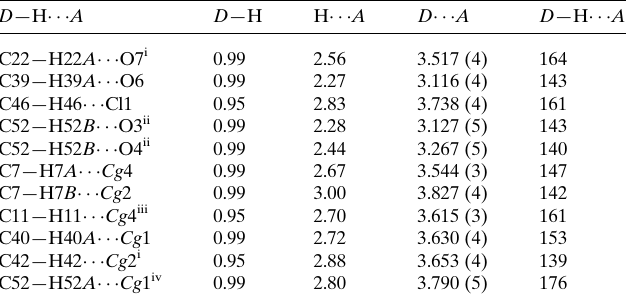
Table 2 Experimental details.